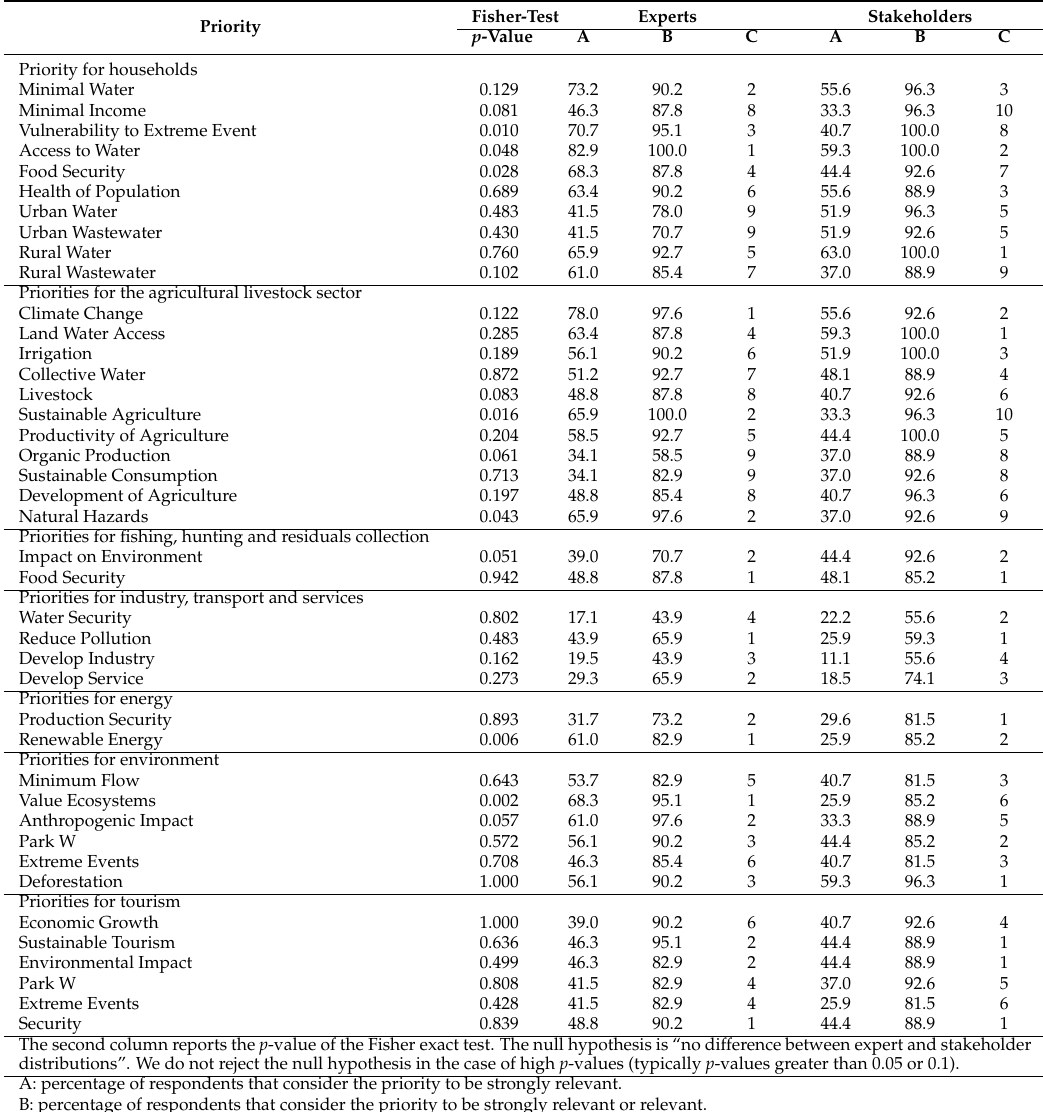
Table 1. Priorities by sector: Expert versus stakeholder points of